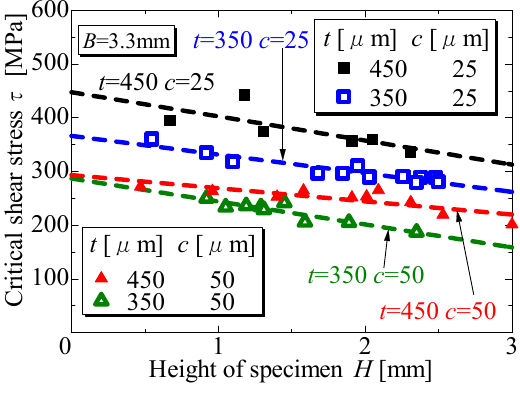
Figure 5. Influence of specimen height on failure stress for specimen width B = 3.3 mm.